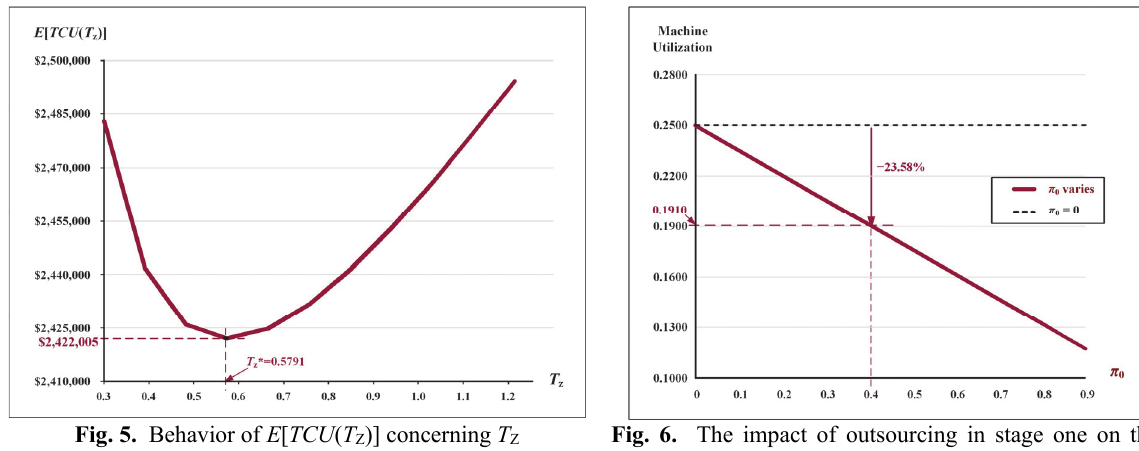
Fig. 5. Behavior of E [ TCU ( T Z )] concerning T Z Fig. 6. The impact of outsourcing in stage one on the machine utilization